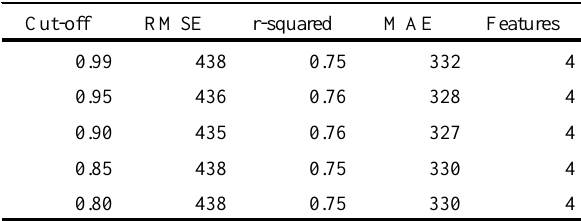
Table 2 - Validation results by cut-off